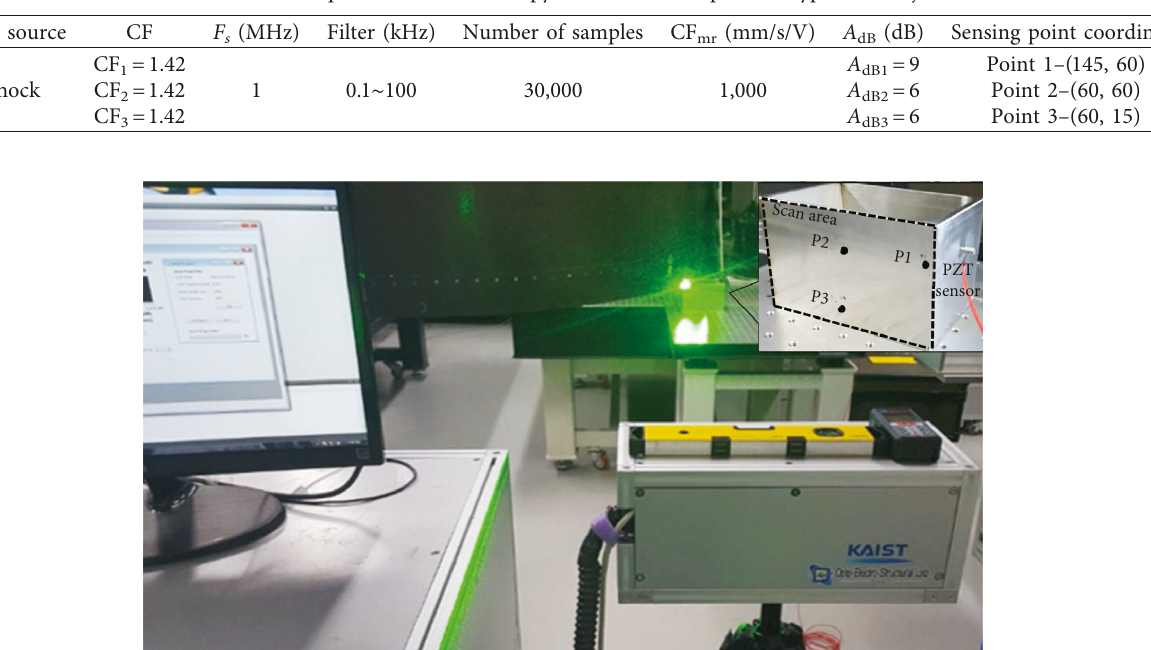
Figure 3: (a) 1/2-inch explosive bolt, (b) 1/2-inch pyrolock, and (c) measurement setup of pyroshock on the open-box-type tension joint. Table 1: Data acquisition condition of pyroshock on the open-box-type tension joint.